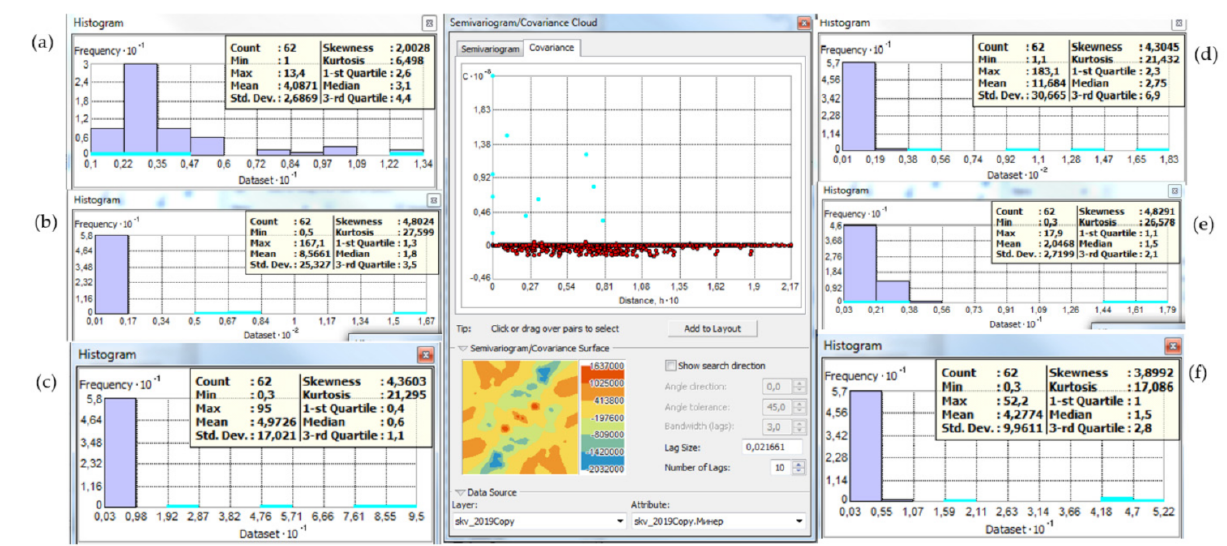
Figure 10. Covariance cloud and attribute histograms: ( a )—HCO 3 , ( b )—SO 4 , ( c )—Cl, ( d )—Na+K, ( e )—Ca, ( f